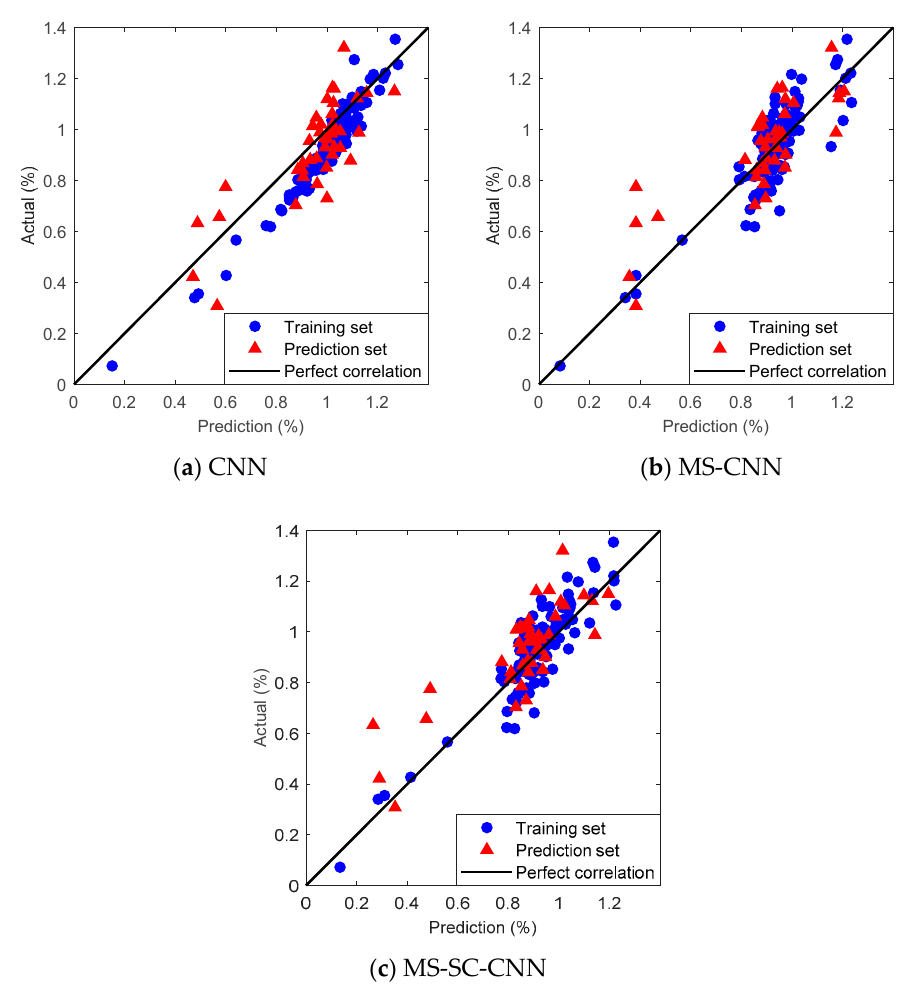
Figure 5. Measured vs. predicated nitrogen content for Pinus massoniana seedling leaves by the regression models of CNN ( a ), MS-CNN ( b ), MS-SC-CNN ( c ).